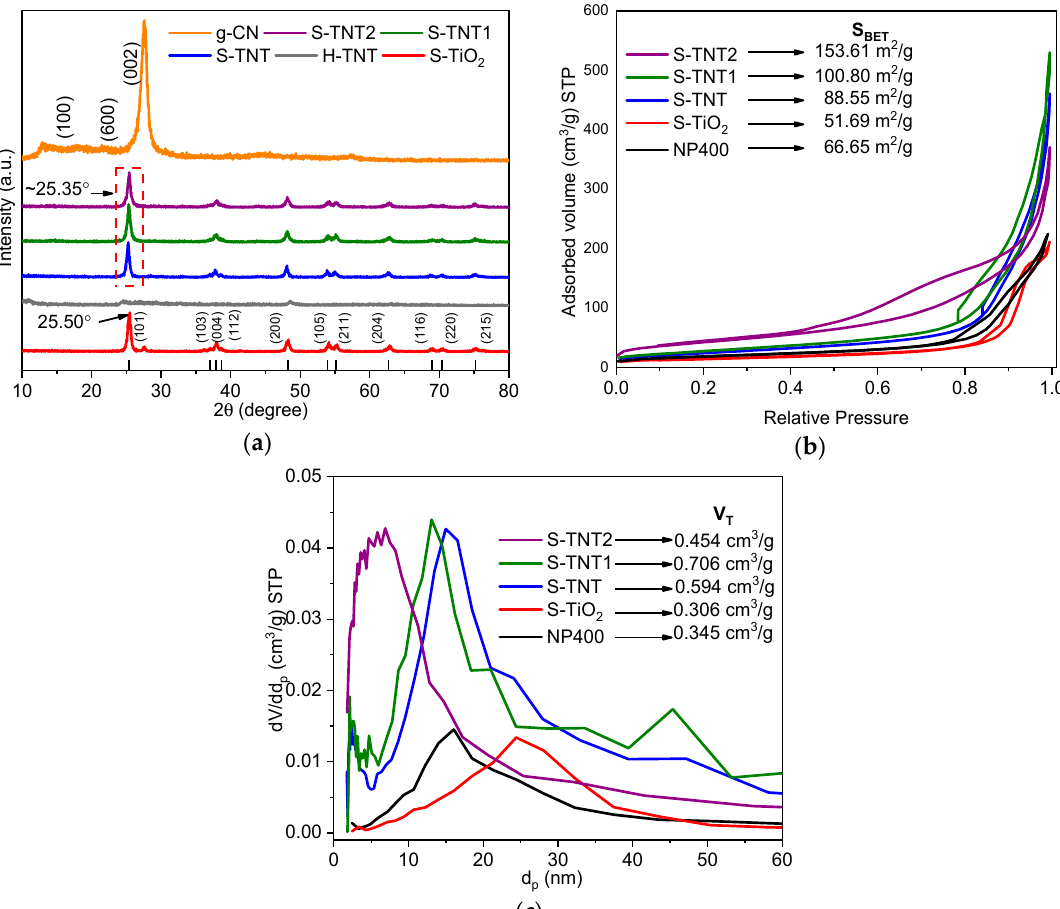
Figure 1. ( a ) X-ray powder diffraction (XRD) patterns of the as-prepared samples S-TiO2, H-TNT, S-TNT, S-TNT1, and S-TNT2; N 2 adsorption-desorption isotherms ( b ) and the pore size distribution (Barrett–Joyner–Halenda (BJH) adsorption) curves ( c ) of commercially available NP400 along with as-prepared sludge generated titanium dioxide (S-TiO 2 ), sludge generated TiO 2 nanotube (S-TNT), S-TNT1, and S-TNT2.